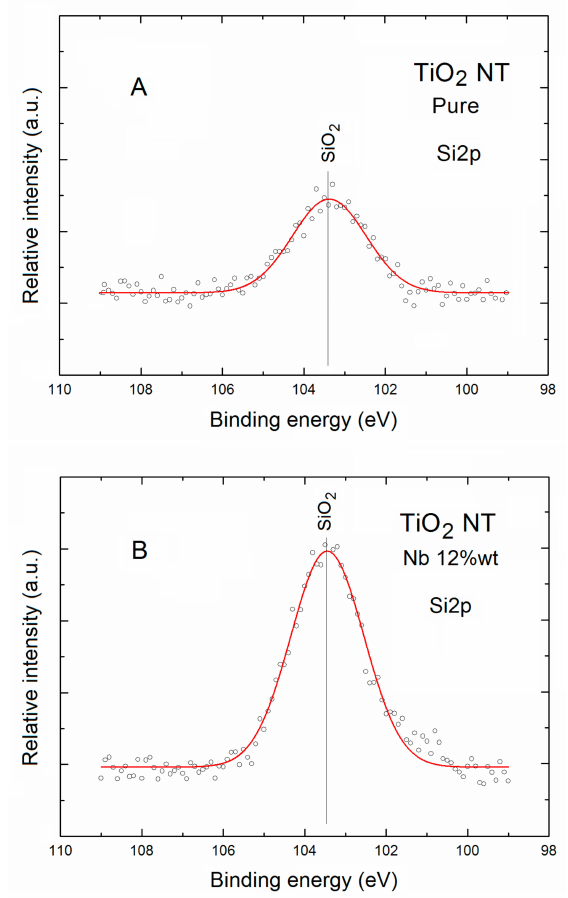
Figure 5. XPS Si2p spectral lines of ( A ) pure and ( B ) Nb-doped TNT after Gauss deconvolution. The circles correspond to the experimental curves after linear smoothing, whereas the color lines correspond to the respective deconvoluted